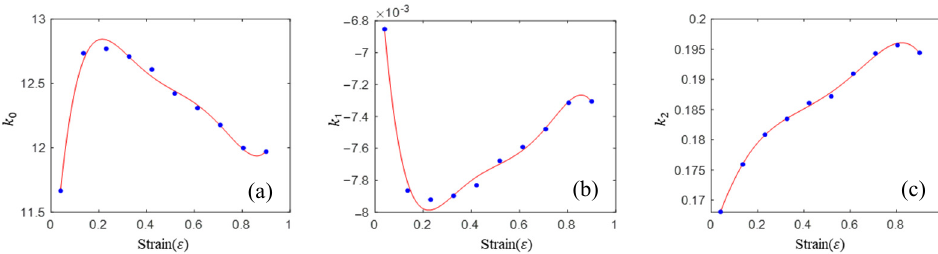
Figure 6. Linear regression values of material parameters at different strain levels and their polynomial fitting: ( a ) Material parameter of k 0 ; ( b ) Material parameter of k 1 ; ( c ) Material parameter of k 2 .